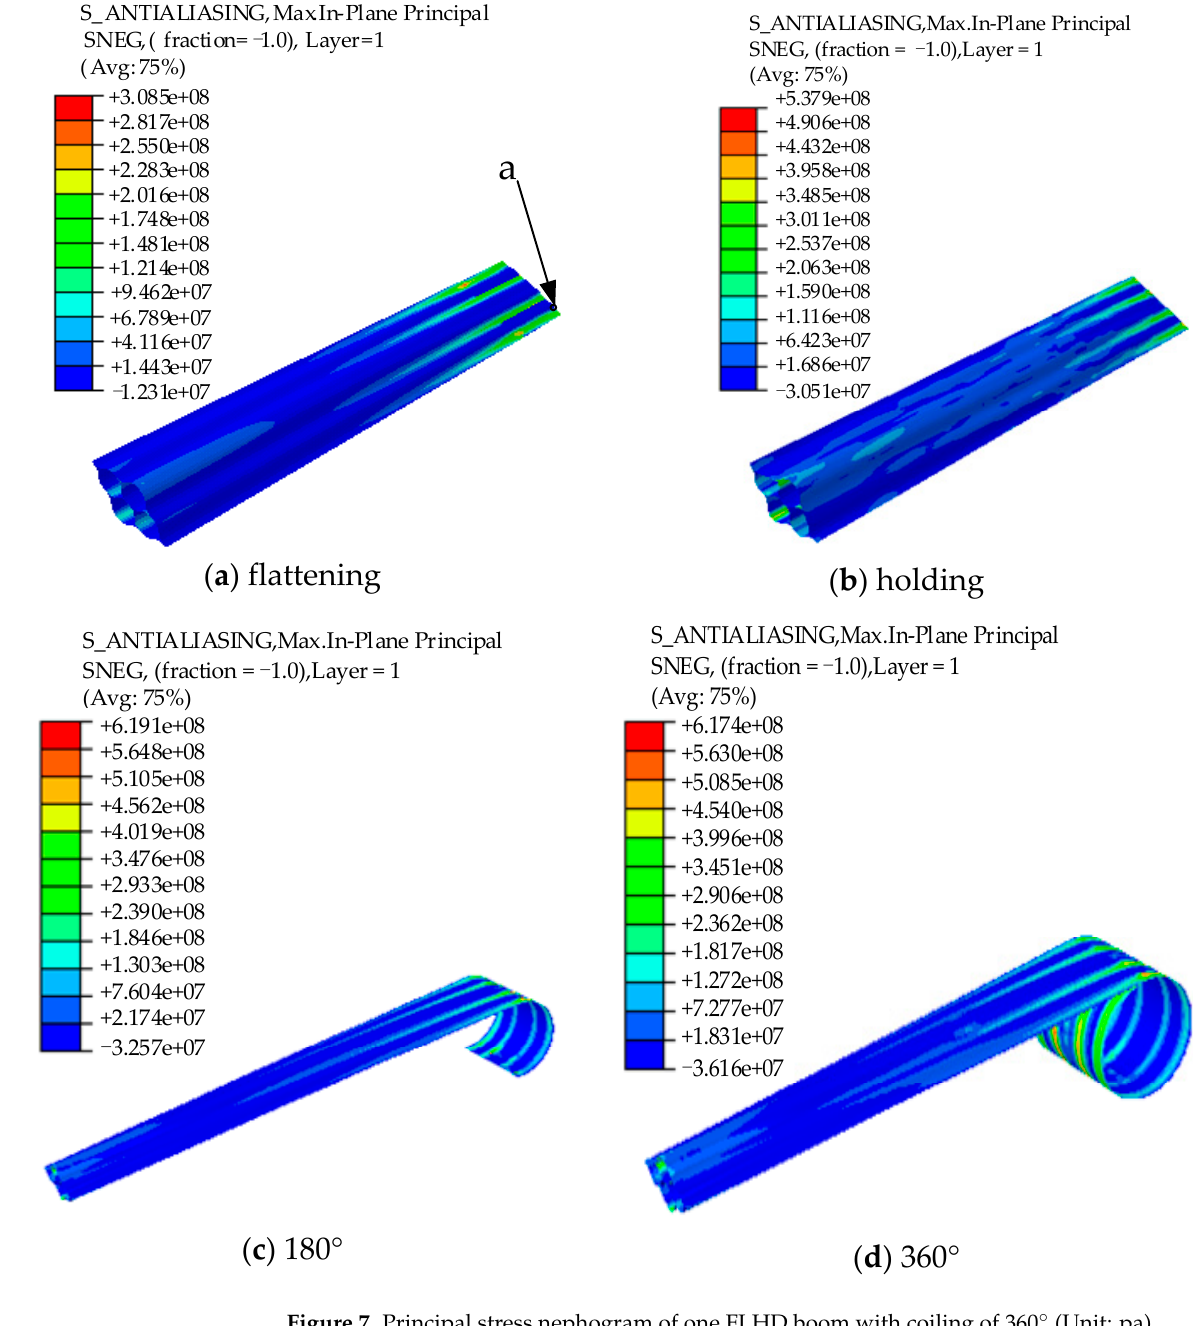
Figure 7. Principal stress nephogram of one FLHD boom with coiling of 360° (Unit: pa).